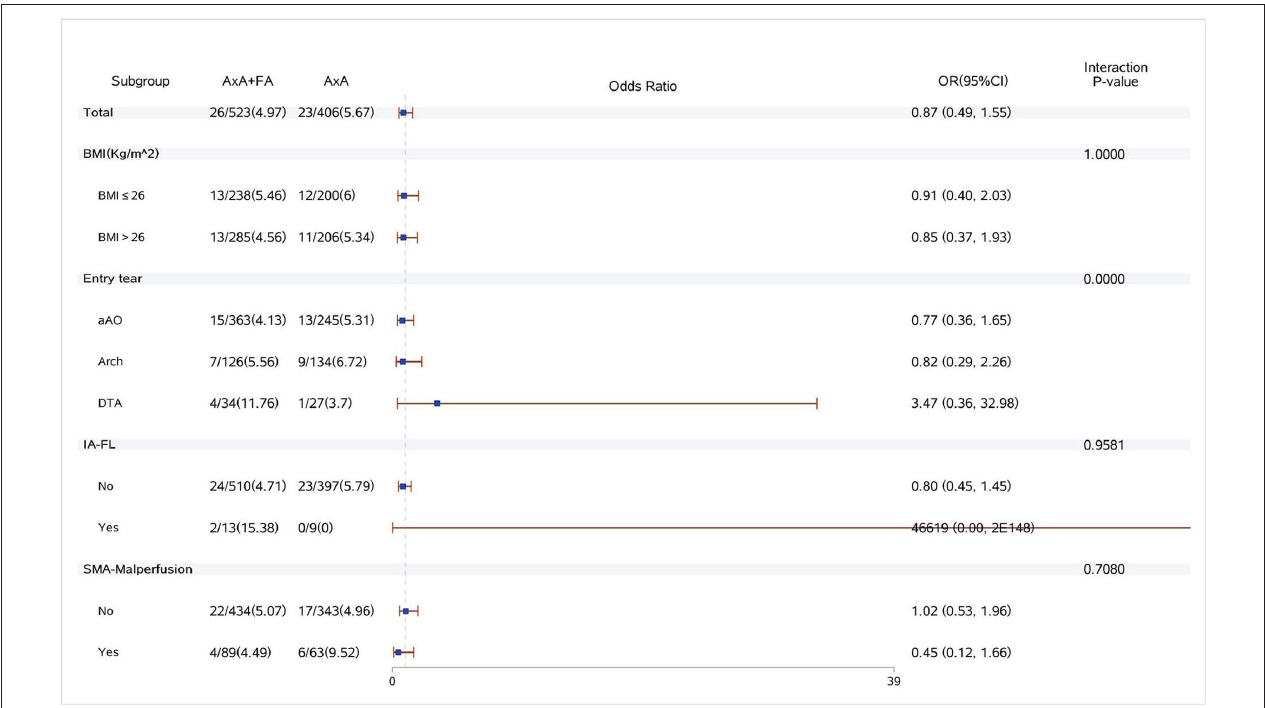
FIGURE 3 | Forest plot of dual arterial cannulation vs. axillary artery cannulation regarding spinal cord injury by subgroups. AXA + FA, axillary artery cannulation + femoral artery cannulation; AXA, axillary artery cannulation; IA-FL, innominate artery originating from false lumen; and SMA, superior mesenteric artery.